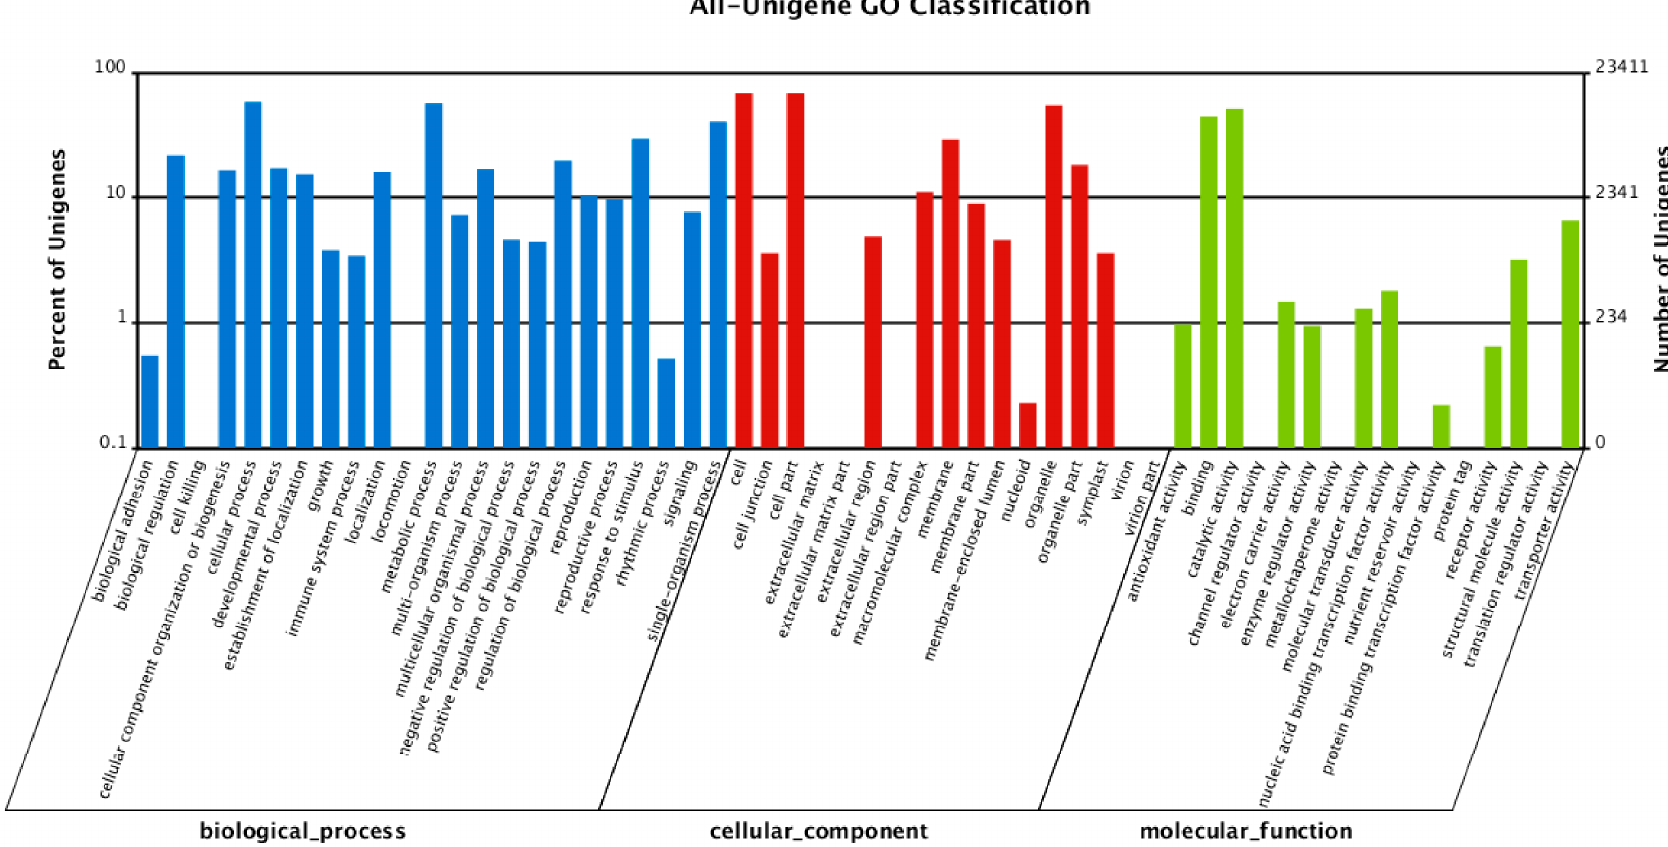
Figure 2. Gene ontology (GO) classifications. GO function is showed in X -axis. The right Y -axis indicates the number of genes with GO functions, and the left Y -axis indicates the percentage in a logarithmic scale.